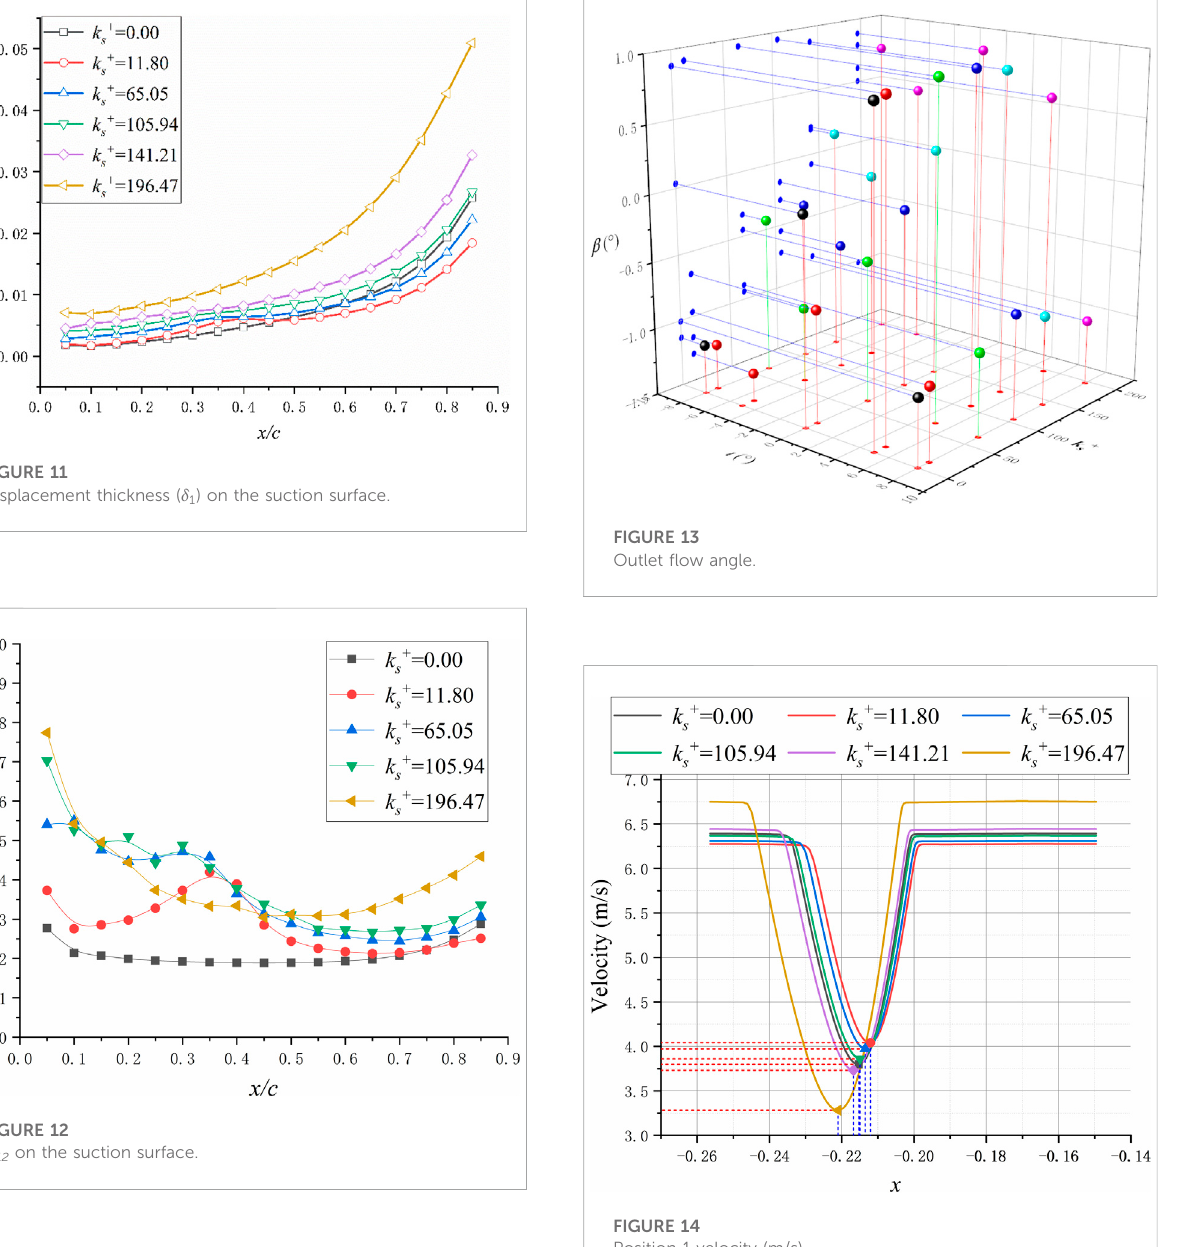
FIGURE 14 Position 1 velocity